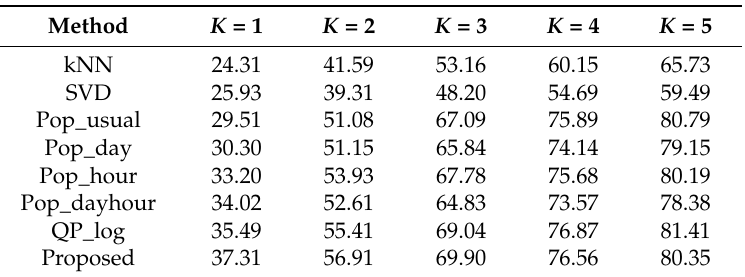
Table 1. Hit rate of TV recommender systems (%).